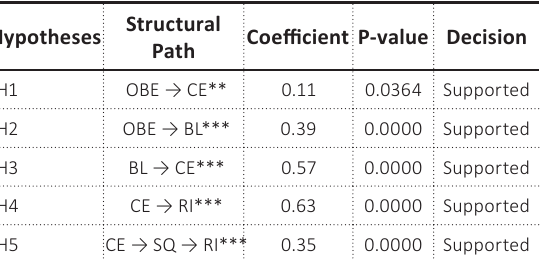
Table 5. Hypotheses